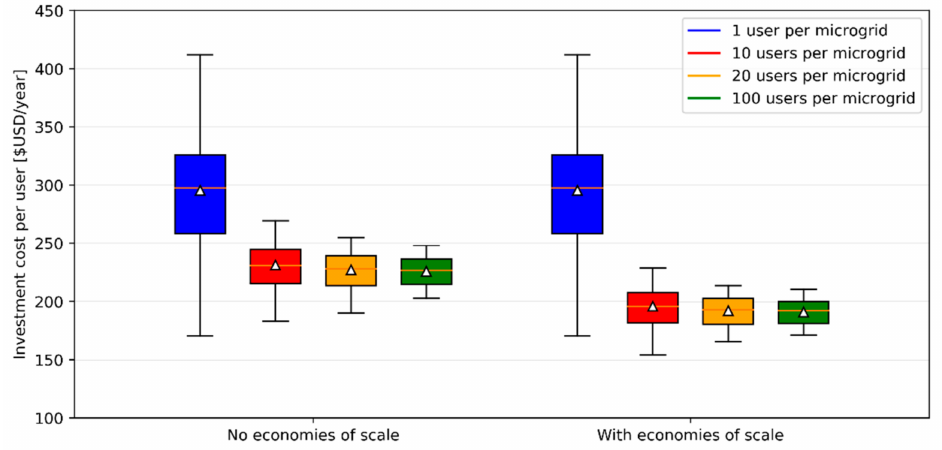
Figure 13. Distribution of investment costs per household for microgrids determined from the stochastic approach, with reliability requirements (Case